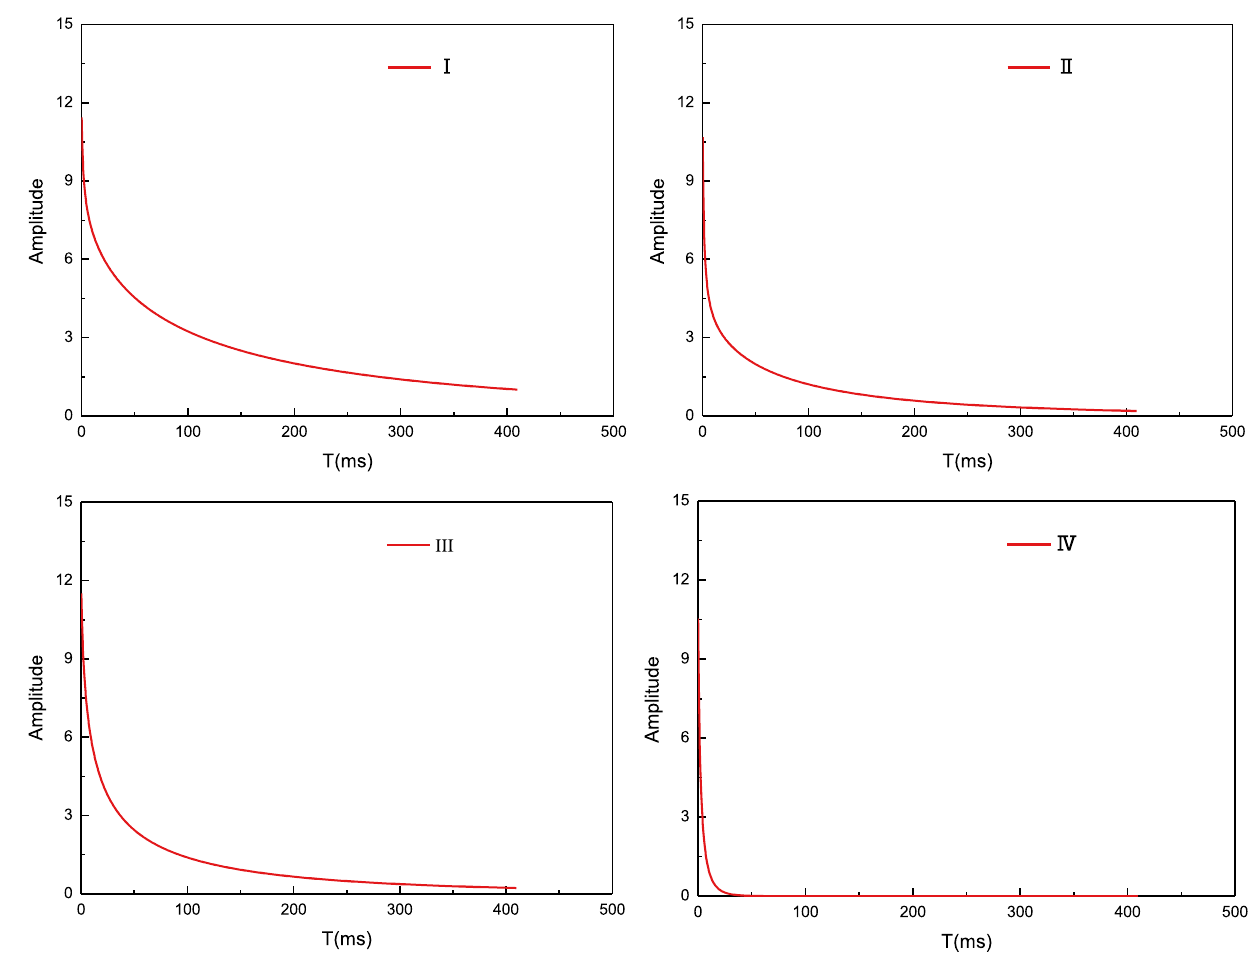
Fig. 14 Nuclear magnetic decay spectrum of rocks with different pore